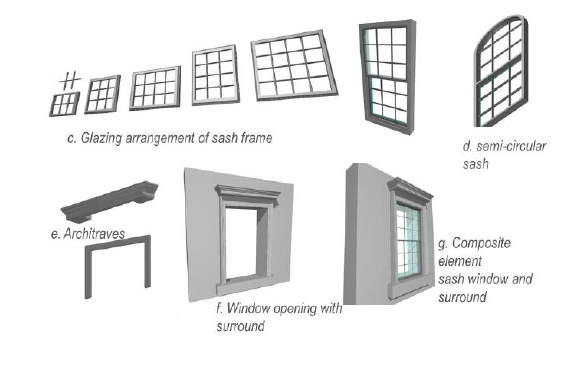
Figure 7: Library Objects